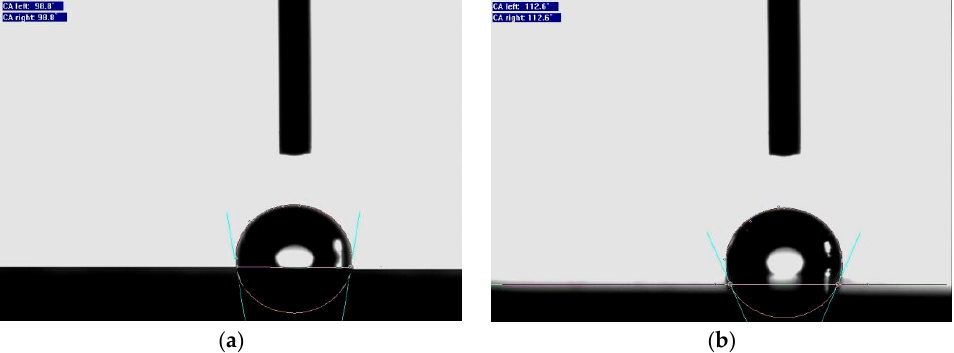
Figure 20. Contact angle measurement image: ( a ) BE-4 modified emulsified asphalt; ( b ) HPFA.